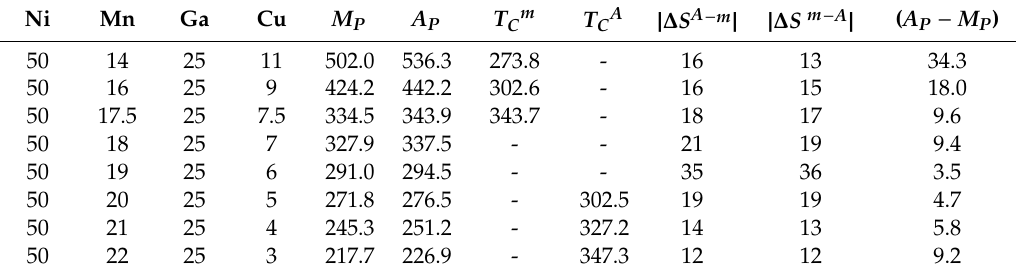
Figure 2. Thermogravimetric curves obtained during cooling/heating cycles performed under a Table 2. Nominal compositions (at %) of the studied alloys, representative temperatures of the MT permanent magnet for alloys with x = 9 and x = 7. The corresponding DSC curves are also shown. ( M P and A P , in K), Curie temperatures for austenite and martensite ( T CA and T Cm , respectively, in K) together with the absolute values of the transformation entropy changes ( | ∆ S A − m | and | ∆ S m − A | ,